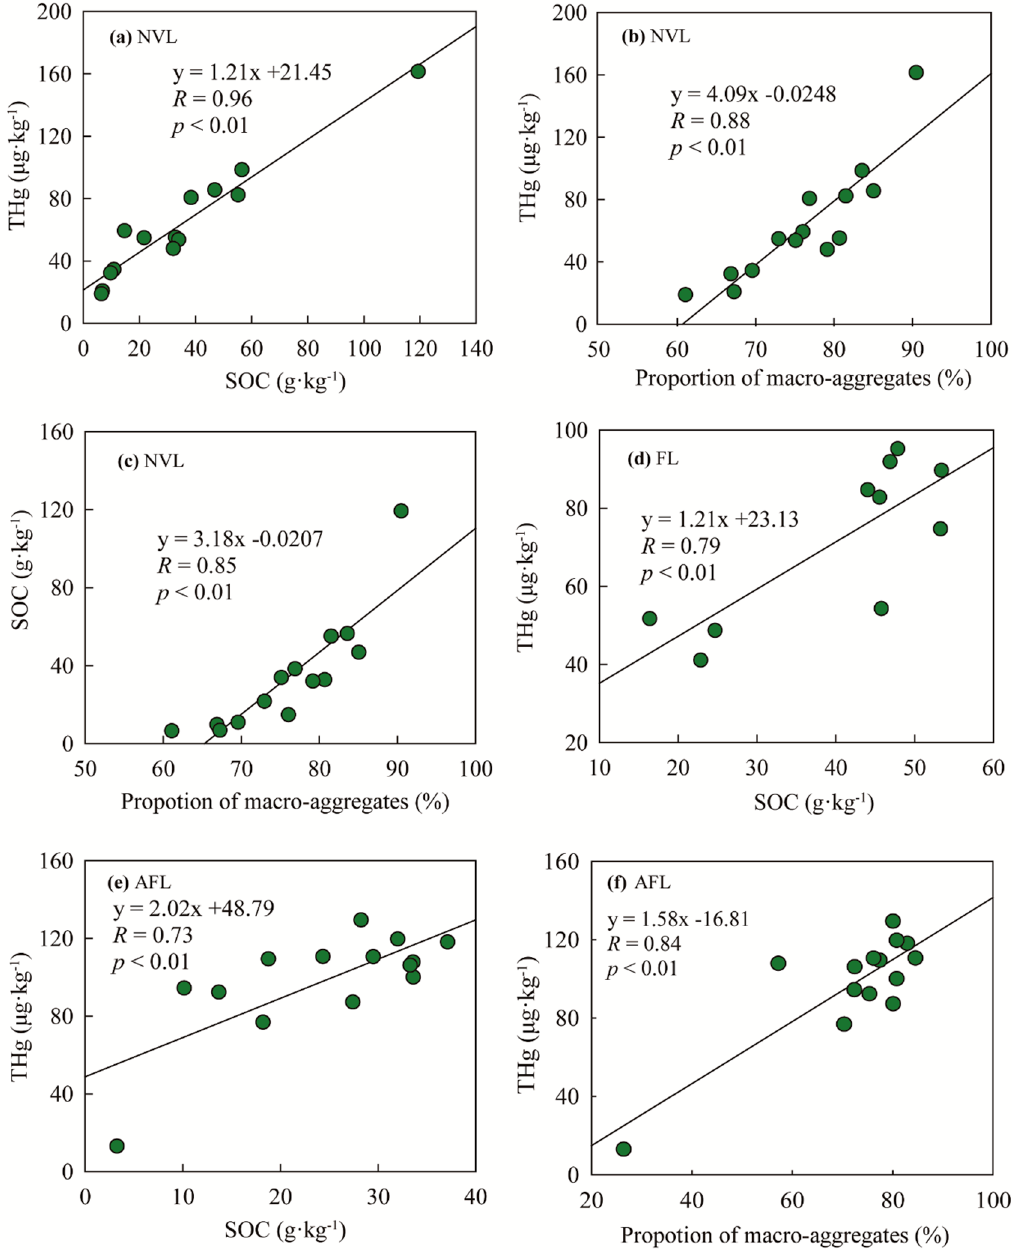
Figure 3. Line regression relationships between THg concentration, SOC concentration, and proportion of macro-aggregates. NVL: native vegetation land; FL: farmland; AFL: abandoned farmland.